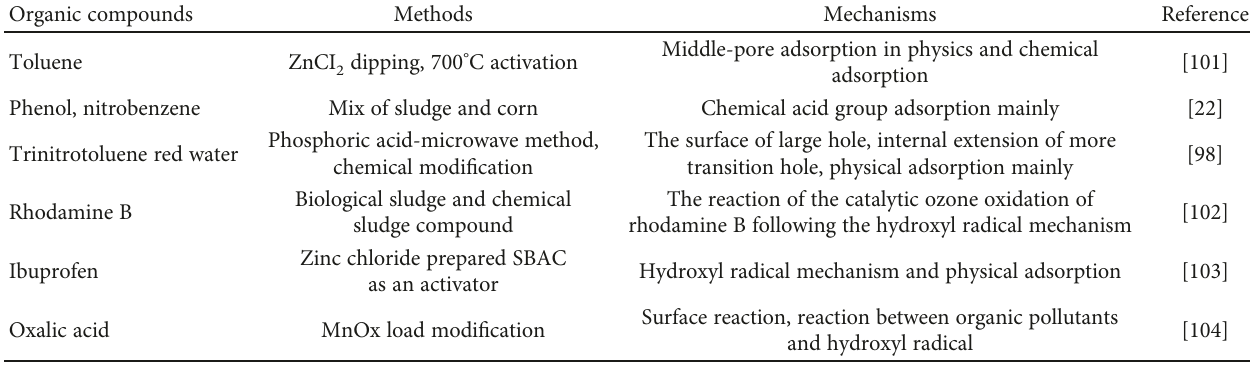
Table 3: Organic compound removal by SBAC: preparation methods and removal